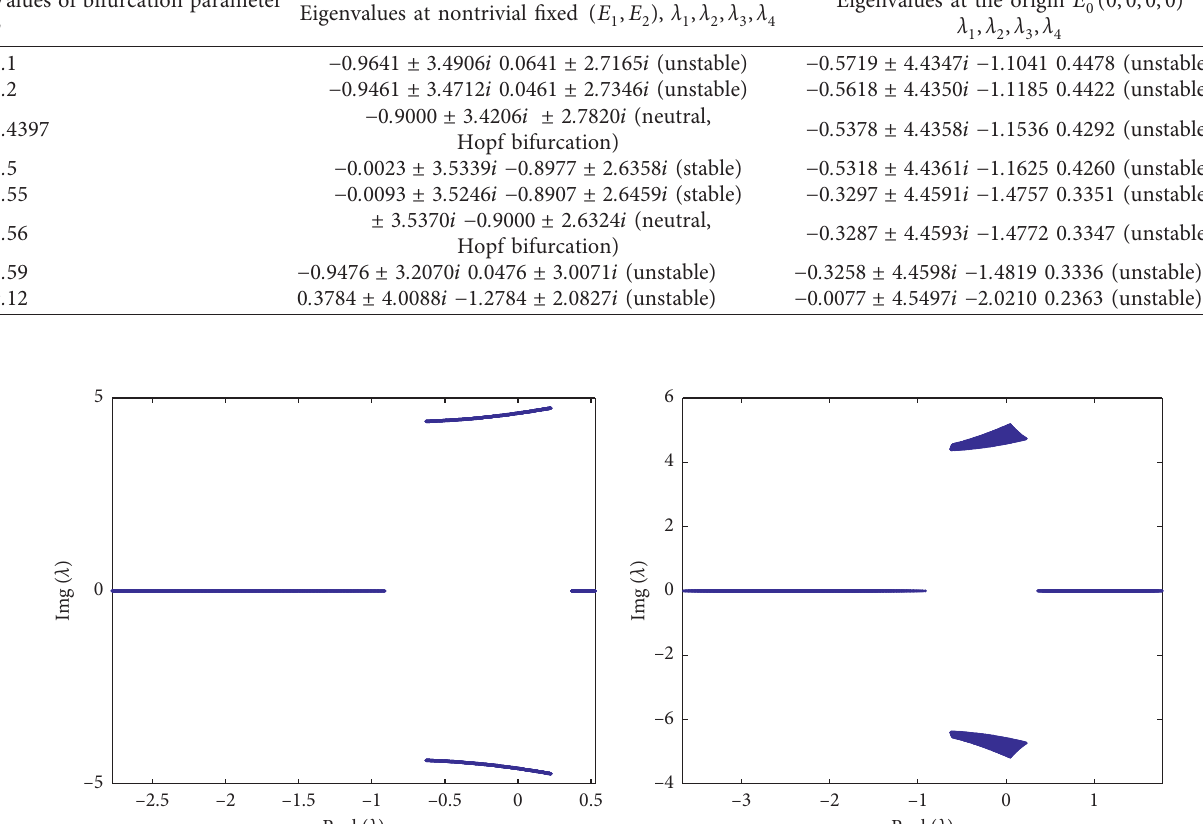
Table 2: Corresponding eigenvalues of each equilibrium point according to the bifurcation parameter b . Values of bifurcation parameter b